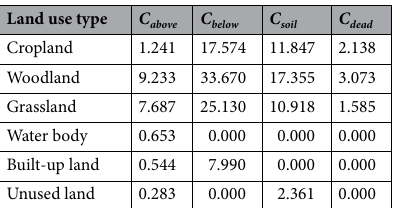
Table 2. Carbon density values of different land use types in the Western Sichuan plateau (t hm −2